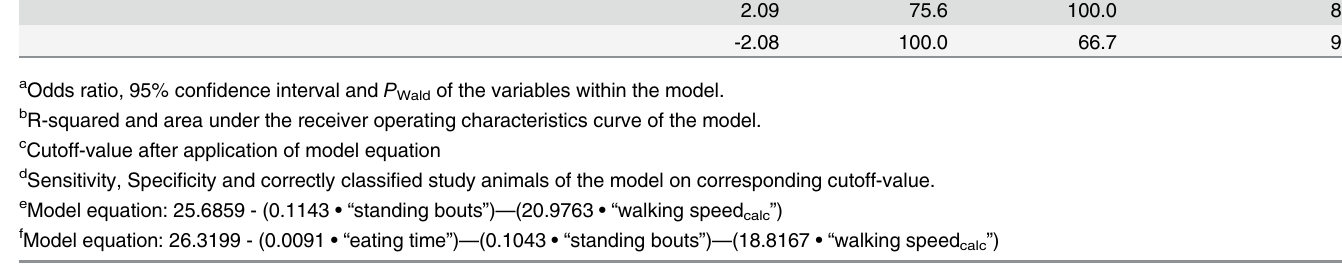
Wald of the variables within the model.